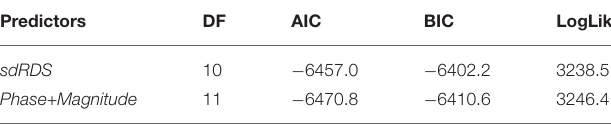
TABLE 2 | Model comparison between sdRDS and Phase+Magnitude.